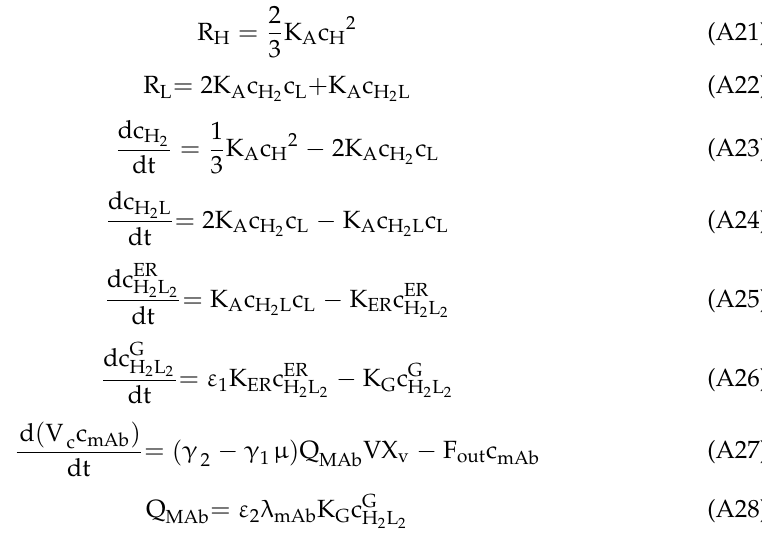
Table A1 reports the list of the parameters with the corresponding mean and standard deviations used for process batch generation. Table A1. Mean (reference) and standard deviation values of the parameters used in process batch generation. Missing standard deviations represent that the parameter is kept constant at the refer- ence